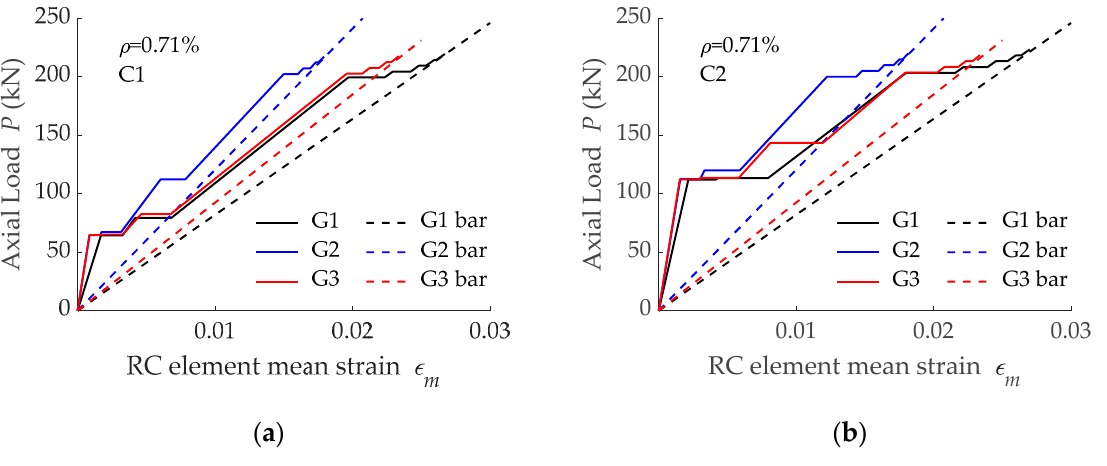
Figure 14. Load-mean strain curves predicted with bars G1, G2, and G3 embedded in: ( a ) concrete C1; ( b ) concrete C2.